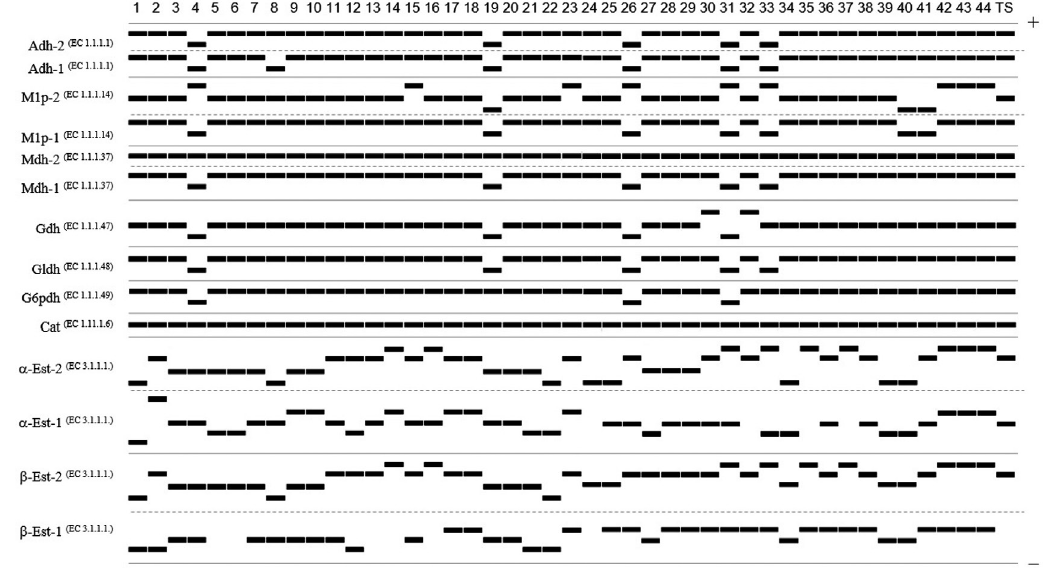
Figure 2- Diagram of the multilocus enzyme electrophoresis (MLEE) patterns of the S. aureus isolates. The migration of the enzymes occurred from the negative pole (cathode) to the positive pole (anode). The isolates are labeled from left to right 1 to 44 (TS corresponds to the S. aureus type strain – ATCC®